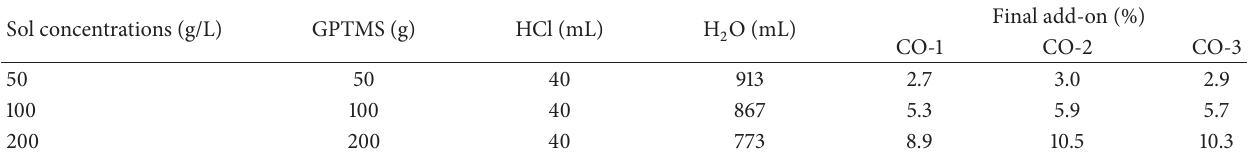
Table 2: Investigated sol formulations.